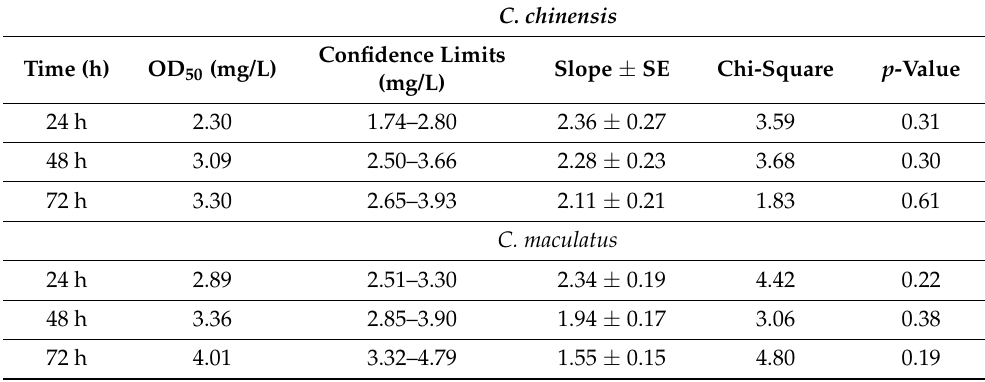
Table 6. Ovipositional deterrence of A. maritima oil against C. chinensis and C. maculatus adults.